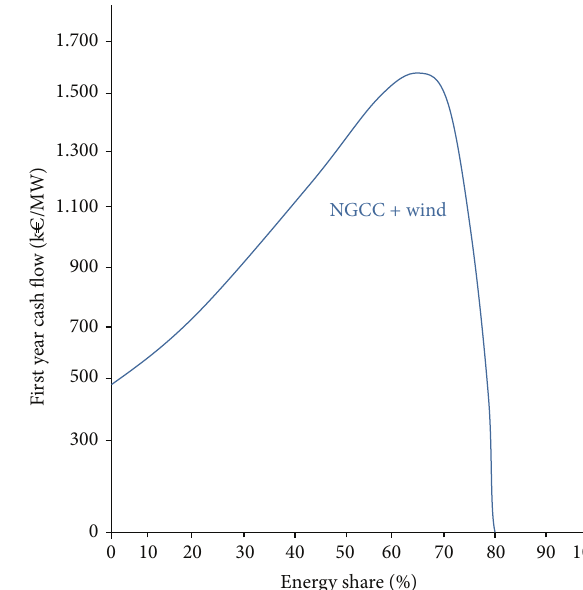
Figure 10: Cash flow for NGCC + wind